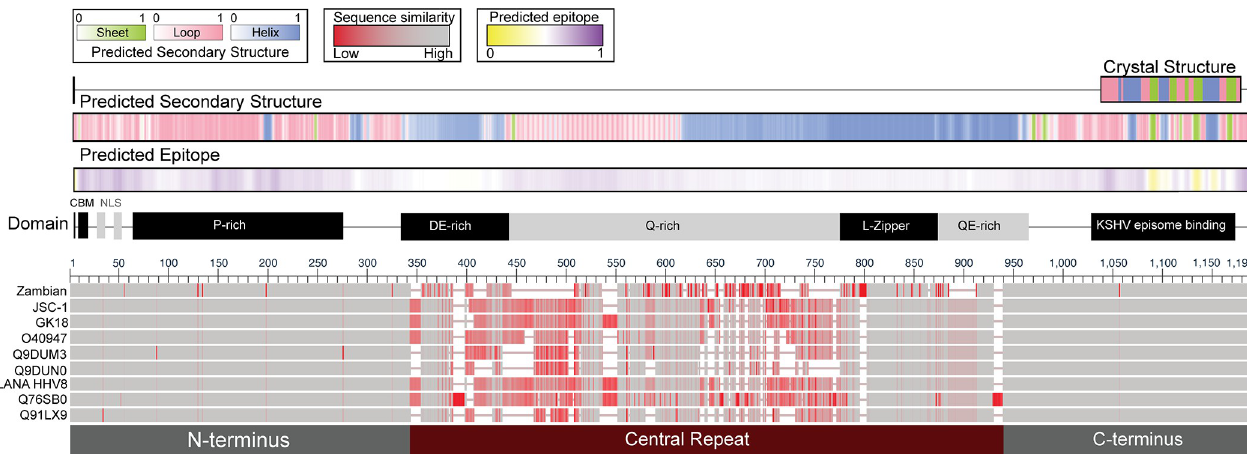
Fig 2. KSHV-LANA protein multiple sequence alignments. The reference LANA sequences (70% Zambian consensus, JSC-1, and GK18) and input library sequences (indicated by their UniProtKB IDs) were aligned, and residues were colored based on their sequence similarity; gray indicates 100% sequence identity, red represents no similarity at a given position. Computationally predicted and crystal secondary structures are annotated and color-coded by type: sheet (green), loop (pink), or helix (blue). Predicted secondary structures are represented in color gradients representing the probabilities (minimum [0; white] and maximum [1; sheet (green), loop (pink), or helix (blue)]). Additionally, the BepiPred-2.0 tool was used to map probabilities of a predicted B-cell epitope. Lastly, functional motifs/domains are annotated directly above the aligned sequences. CBM : Chromosome binding motif , NLS : Nuclear localization sequence , P- rich : Proline-rich region , DE-rich : Aspartic/Glutamic acid-rich region , L-Zipper : Leucine zipper motif , QE-rich : Glutamine/Glutamic acid-rich region .